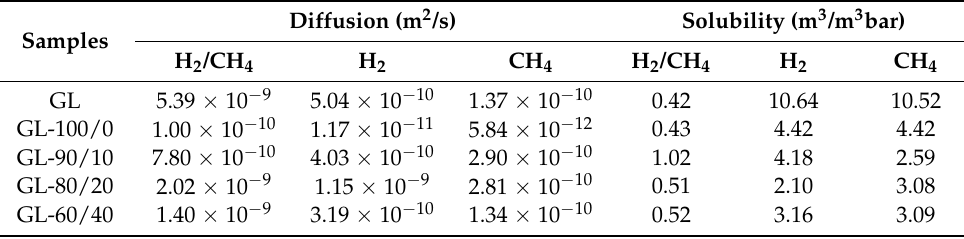
Table 3. Membrane characteristics: diffusion and solubility